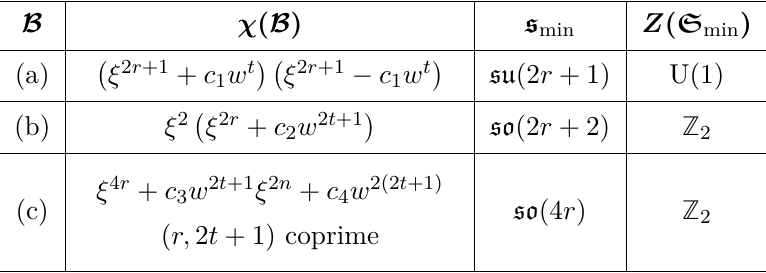
Table 3 . Irreducible blocks and stabilizer